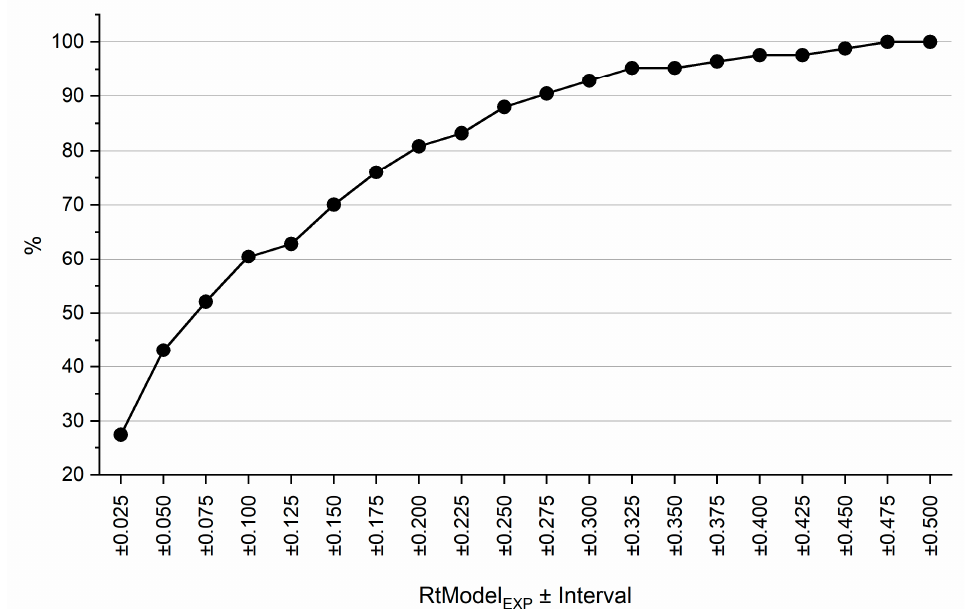
Figure 7. Portion (%) of pairwise RC values calculated from RtModel QSRR which falls within certain interval RC values calculated from RtModel EXP . See text for details.